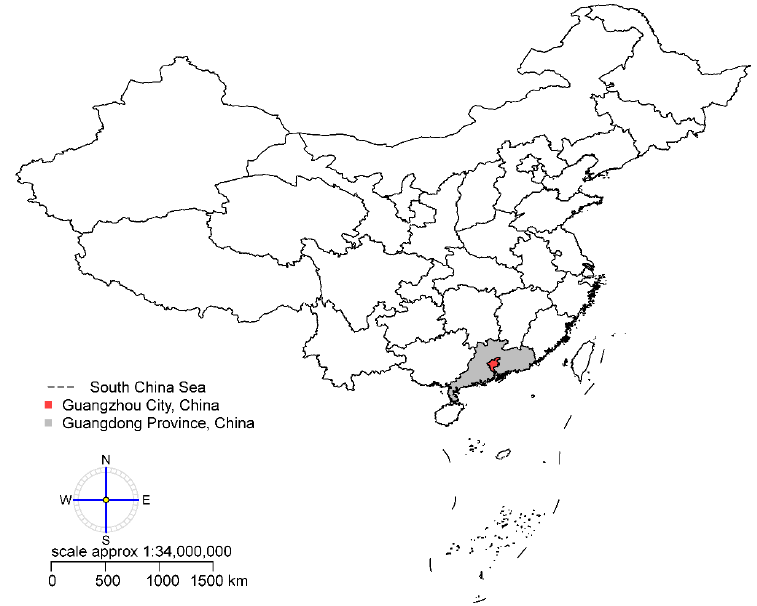
Figure 1. Geographic location of study area in Guangzhou, China.